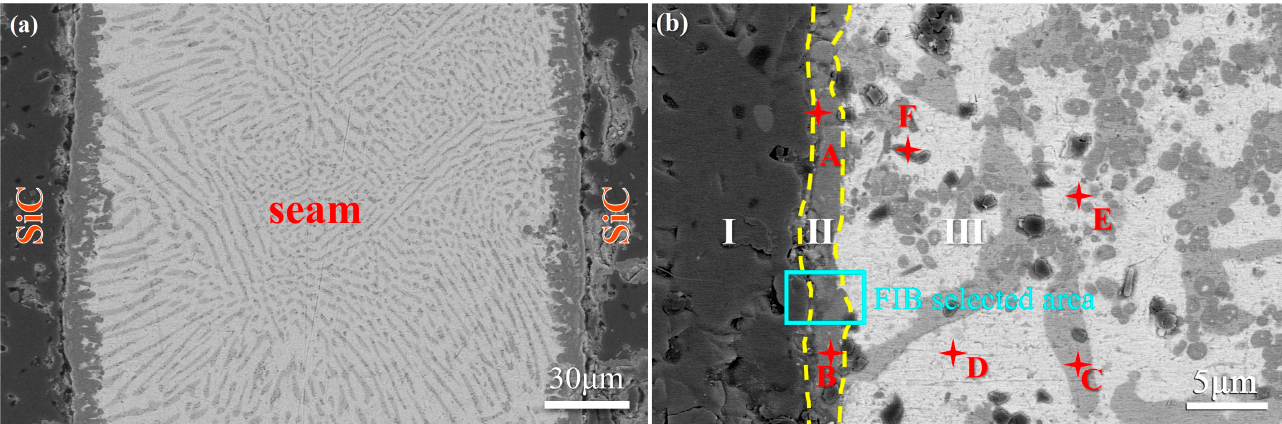
Figure 4. The SEM images of SiC joint brazed with AgCuTi + 1 wt% LAS composite brazing filler at 900 °C /10 min ( a ) microstructure morphology of the whole brazing joint; and ( b ) local magnification of reaction layer.